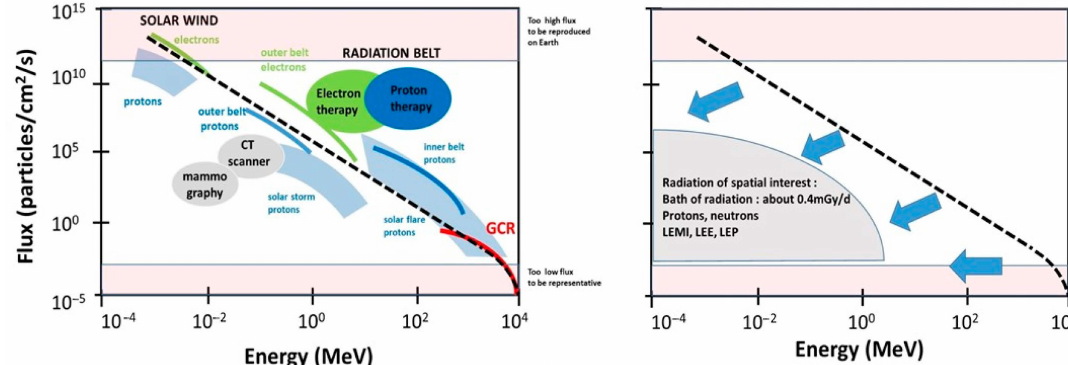
Figure 1. Schematic representation of the 3 major sources of space radiation as a function of energy and flux: Galactic cosmic radiation (GCR), solar radiation component and Van Allen radiation belt. Left panel. The dotted line represents the general relationship between flux and energy. The confidence zones represent the physical features of rays and particles used in proton therapy, electron therapy, computerized tomography (CT) scan and mammography. Right panel. Through their interaction with the shielding, space radiation is degraded in nature, flux and energy to give protons, neutrons, low-energy-metal ions (LEMI), low-energy-electrons (LEE), low-energy-protons (LEP) and a “bath” of residual radiation at about 0.4 mGy/d [6]. Blue arrows represent the effect of the spacecraft shielding to the